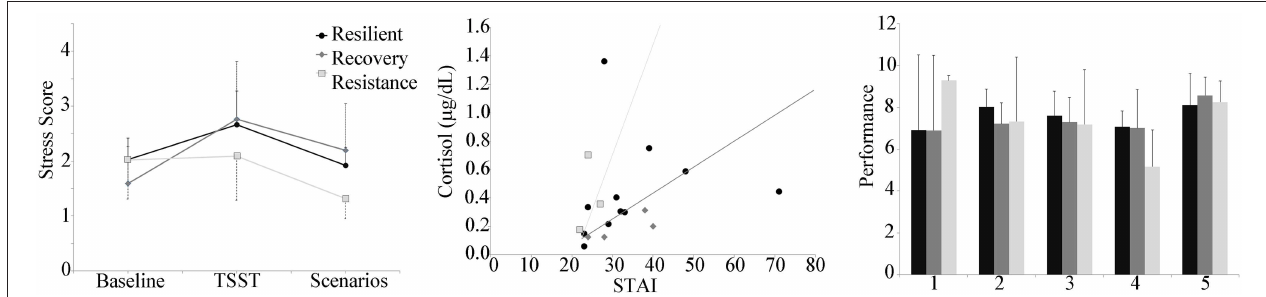
FIGURE 6 | Left panel: Stress score by group plotted during the baseline, TSST, and throughout the 5 scenarios. Center panel: Decision boundaries of stochastic gradient descent linear classifier of resilience group using baseline cortisol and baseline STAI. Right panel: Performance by resilience group, showing a decrease in performance over the first 4 scenarios for the resistant group compared to much less variability in performance for the resilience and recovery